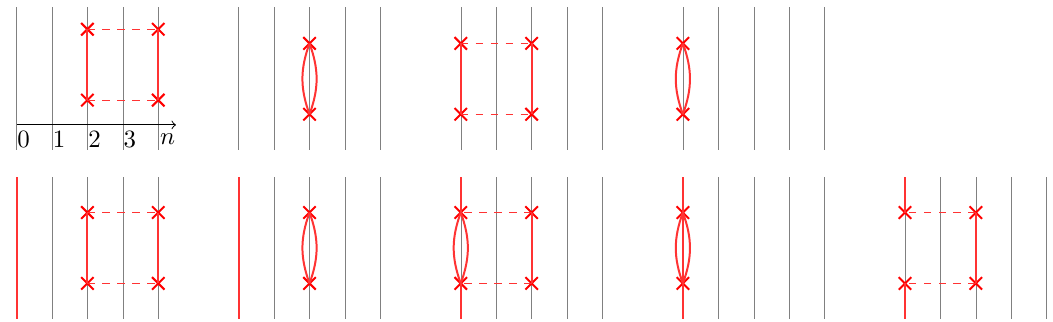
Figure 2. Diagrams contributing at second order in perturbation theory to the vacuum energy (top row) and to the energy of the first excited state | χ i = a † we have intermediate two-particle states, while in the bottom row, we have intermediate one and three particle